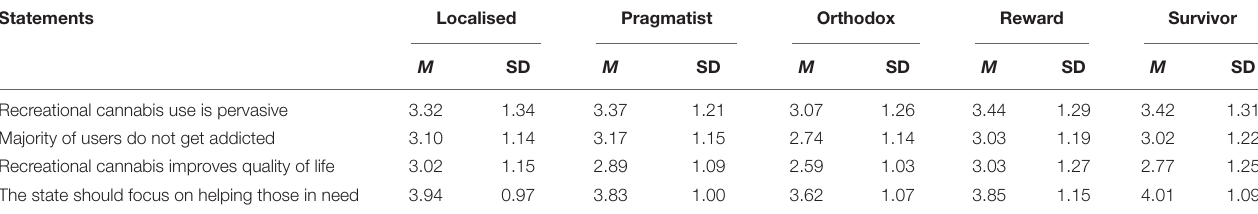
TABLE 5 | Descriptive statistics for each worldview.